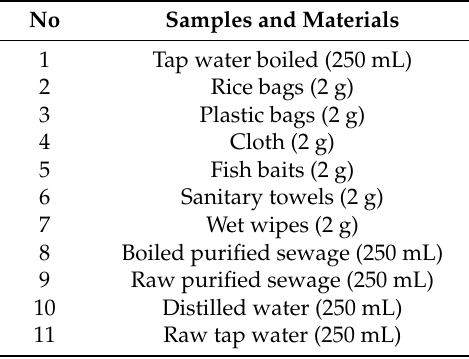
Table 5. List of samples and materials analyzed by SPE/HPLC/DAD-UV-Vis